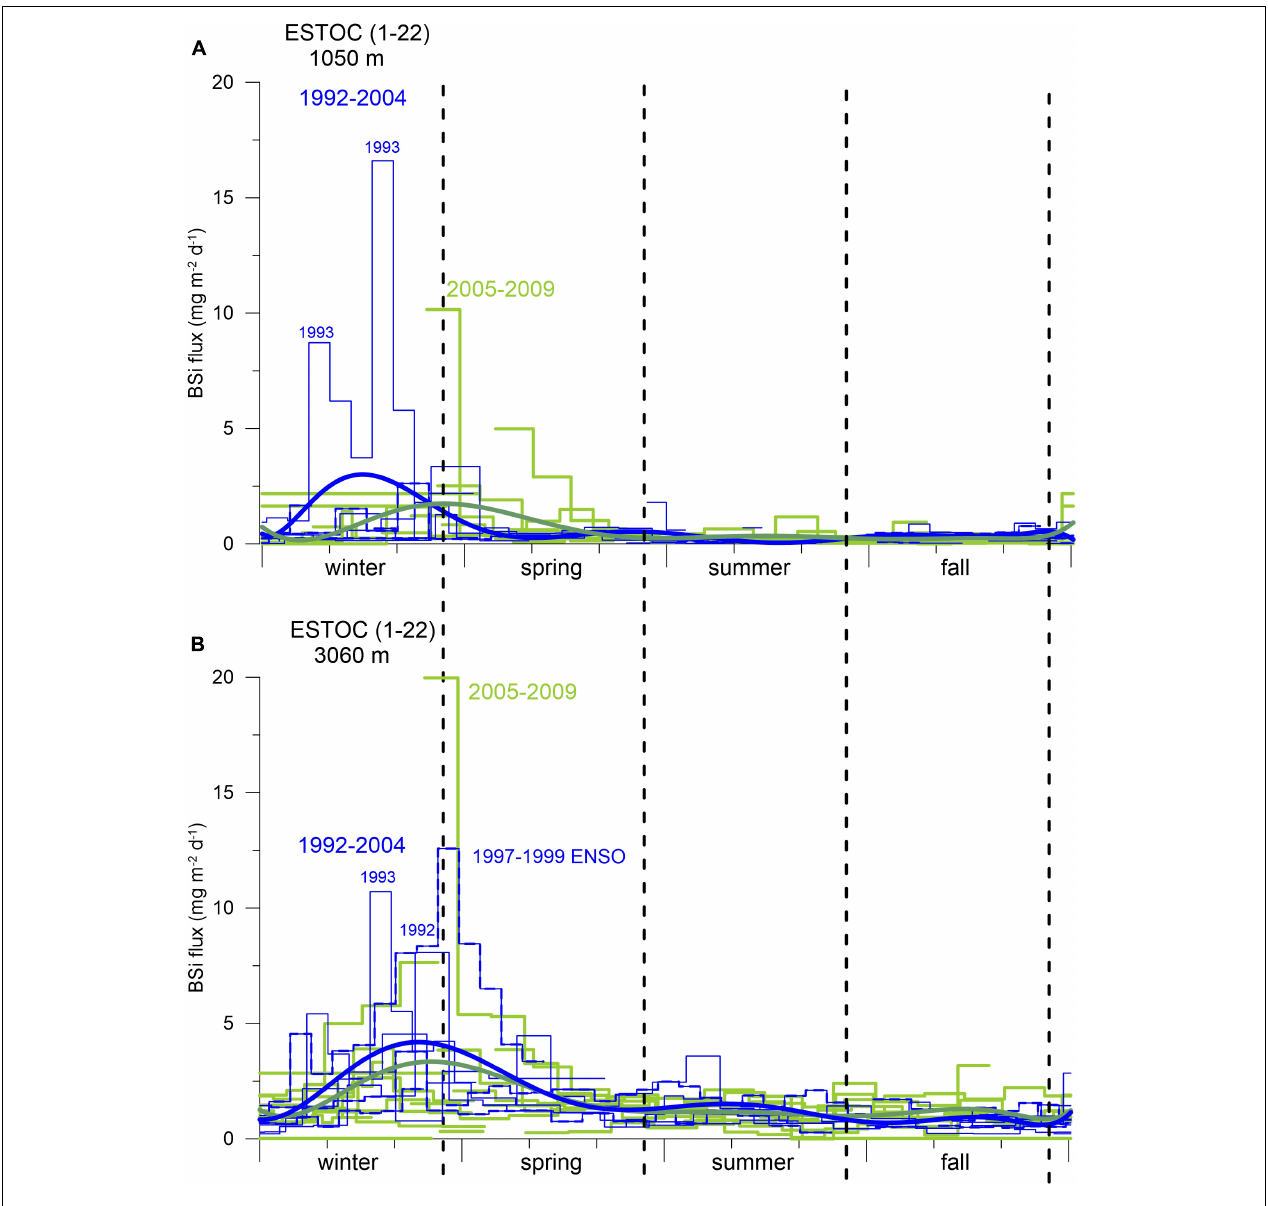
FIGURE 11 | Annual cycles of BSi fluxes from the individual cup-by-cup data for the 1 km (A) and 3 km (B) traps from 1992 to 2004 (blue line) and for 2005–2009 (green line). The extreme 1997–1999 ENSO cycle is additionally marked with a stippled blue line. A polynomial fit (thick blue line for 1992–2004; thick green line for 2005–2009) indicates small displacements of the BSi flux maxima from winter to spring. Seasons are indicated by vertical hatched lines.